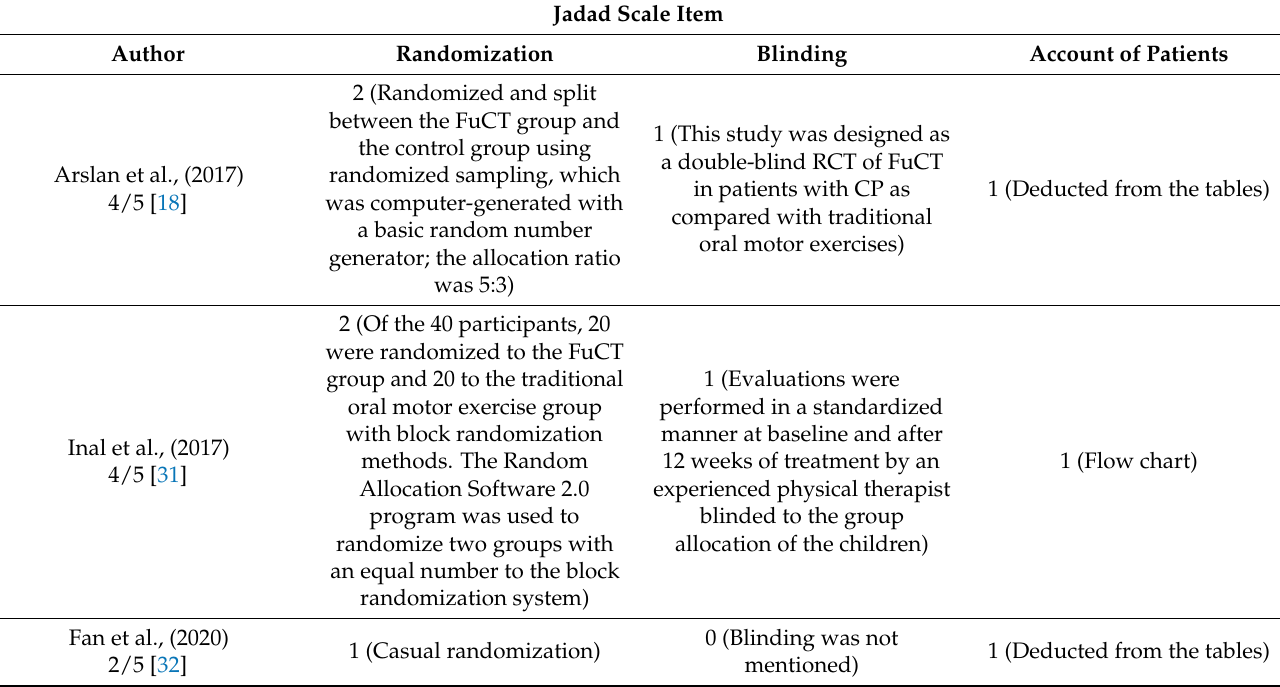
Table 3. Risk of bias according to the PEDro